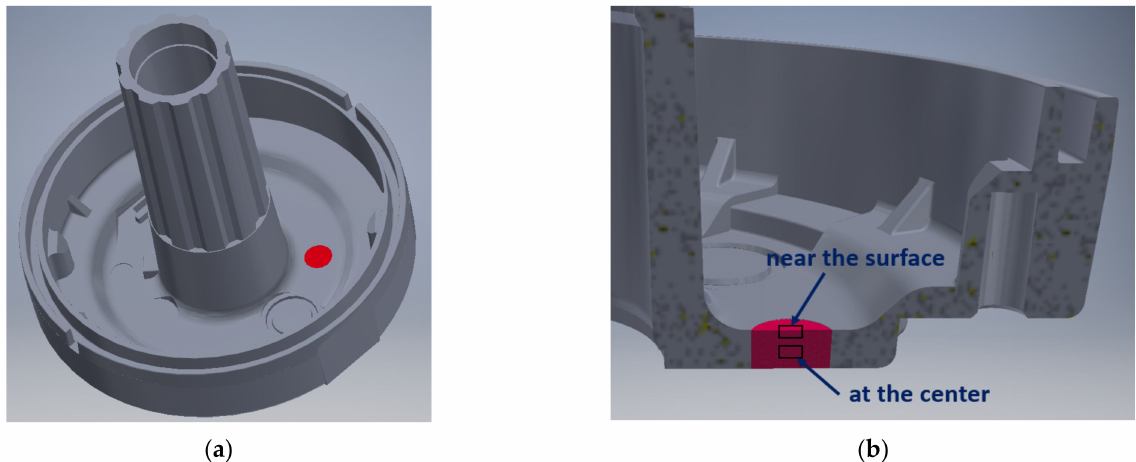
Figure 2. Place of sampling (red) of the casting for microstructure analysis: ( a ) Site within the casting; ( b ) Specimen regions evaluated.